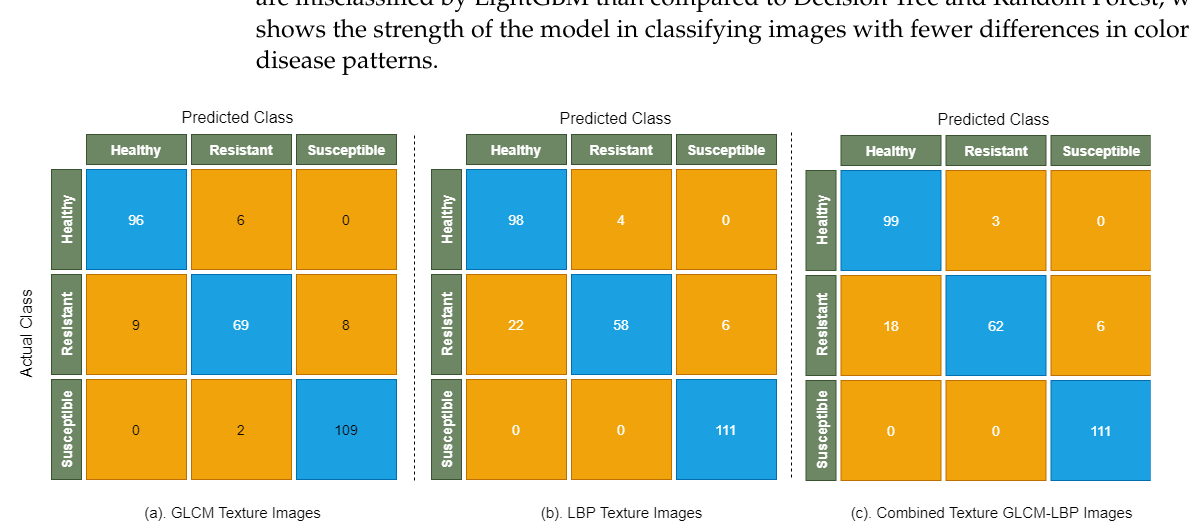
Figure 8. Confusion matrix of LightGBM on GLCM, LBP, and combined texture GLCM-LBP